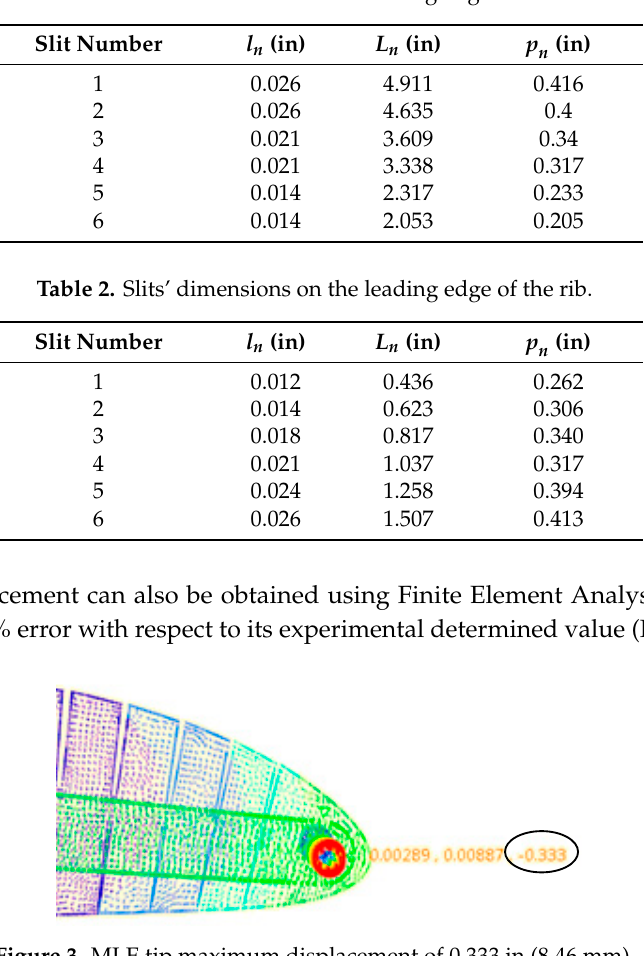
Table 1. Slits’ dimensions on the trailing edge of the rib.